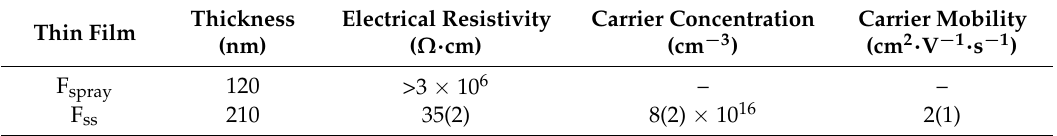
Table 1. Thickness and electrical resistivity, carrier concentration, and carrier mobility of F spray and F ss .